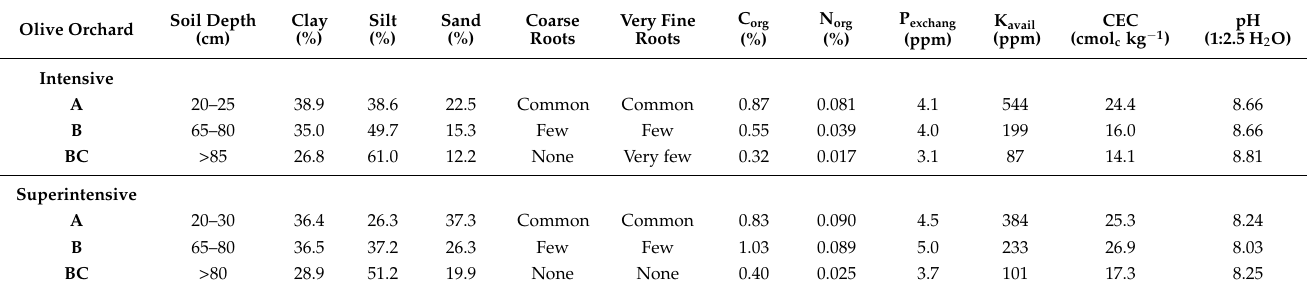
Table 1. Soil properties from the soil profile descriptions in the soil pit created at each of the olive orchards in 2018. Letters A, B and C refer to soil horizon from the soil profile description. C org : organic carbon (Walkley–Black method), N org : organic nitrogen, P exchang : exchangeable phosphorus, K avail : available potassium, CEC: cation exchange capacity; coarse roots refer to those